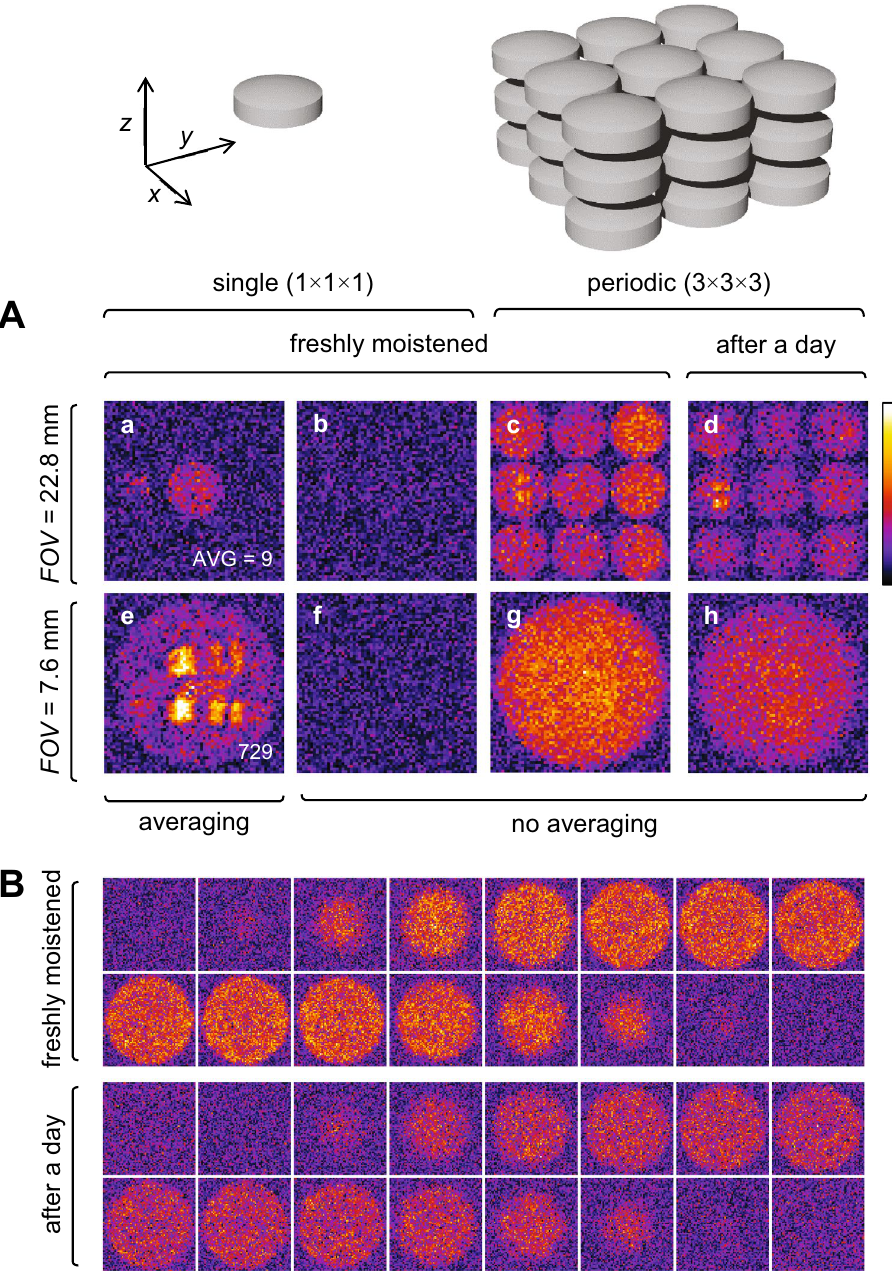
Figure 4. SPI images of tablets. ( A ) 2D SPI images of (a,b,e,f) a single tablet and of (c,d,g,h) a periodic sample of tablets at the FOV equal to: (c–d) triple and (e–h) single unit cell size. (b,f) The single tablet sample does not produce a detectable signal. (a,e) With sufficient averaging the signal becomes comparable to that of (c,g) the periodic sample without averaging. (d,h) After a day, this signal is lower due to moisture loss. ( B ) 3D SPI images of the periodic tablet sample freshly moistened and after a